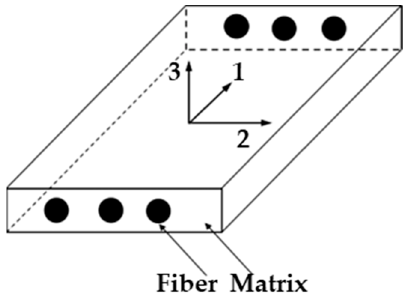
Figure 3. Coordinate system of an orthotropic composite strip.